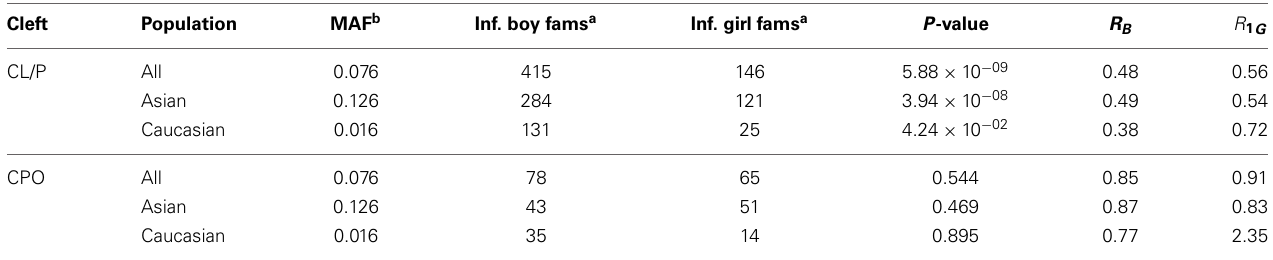
Table 7 | PIX-LRT analysis results of SNP rs5981162, located in the intergenic region between ENFB1 and PJA1 at basepair 68318753. Cleft Population MAF b Inf. boy fams